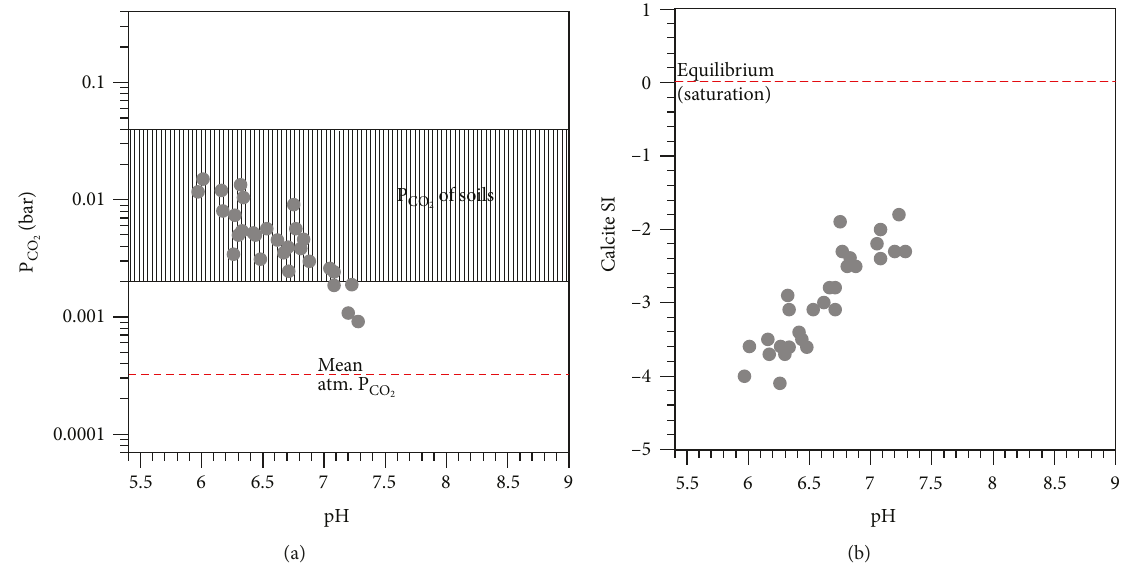
Figure 3: (a) Correlation diagram of pH vs. P (b) Correlation diagram of pH vs. calcite saturation index.